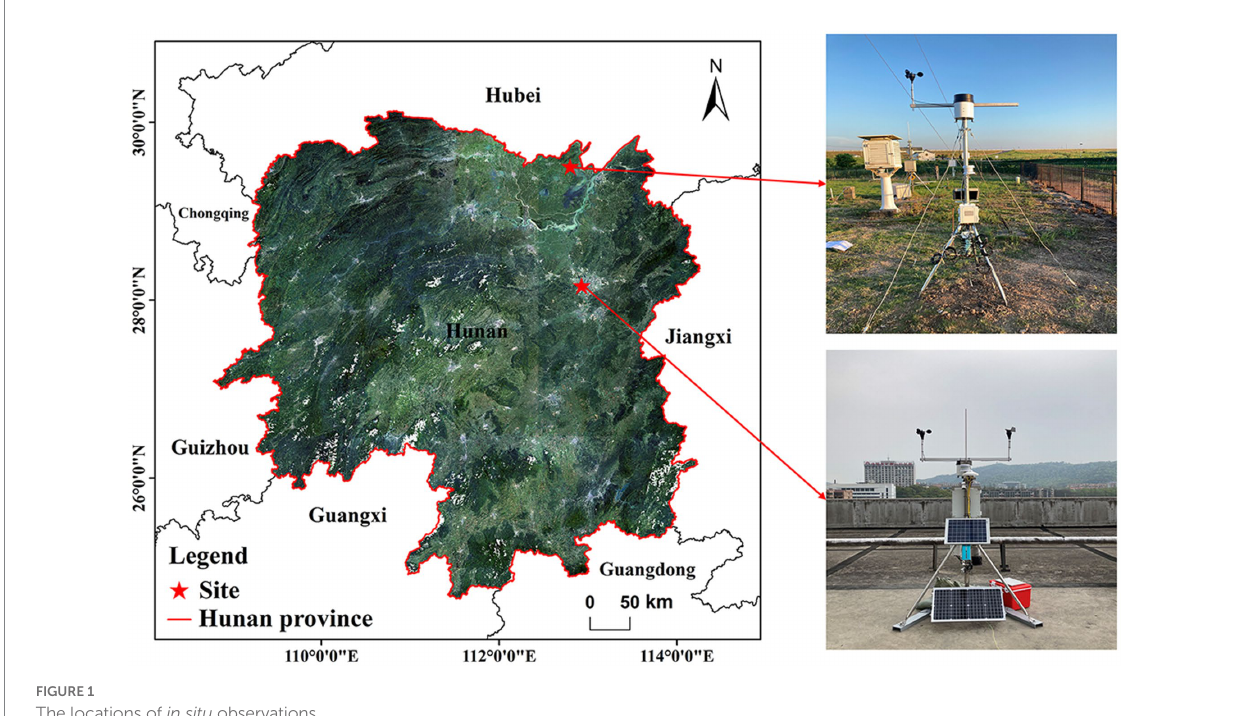
FIGURE 1 The locations of in situ